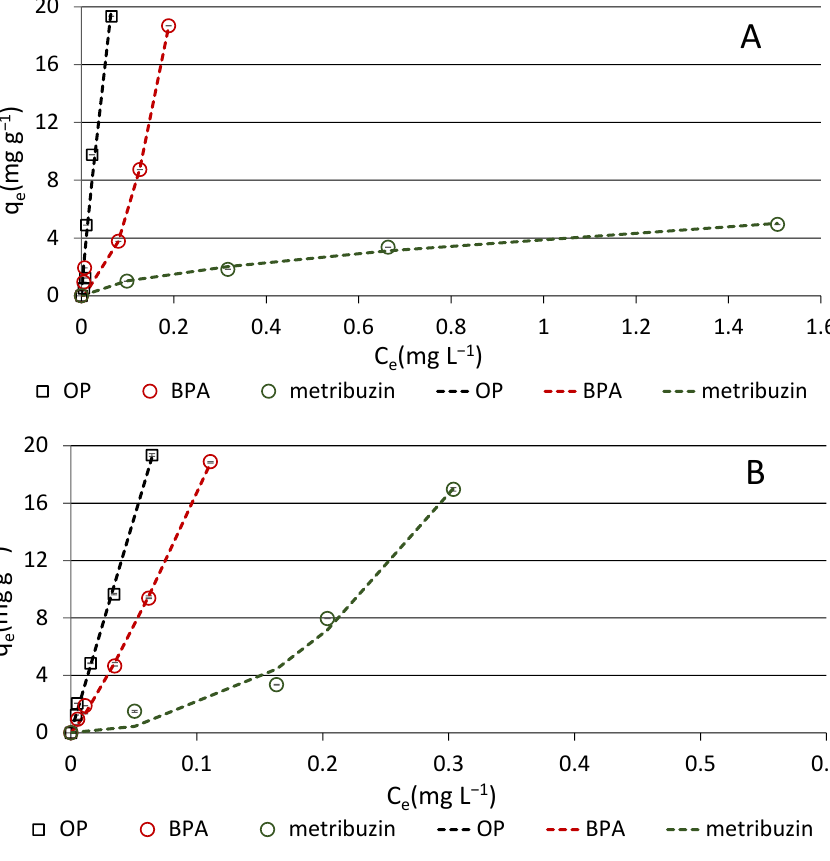
Figure 6. Adsorption isotherms of the compounds onto biochar conducted at temperatures of 10 °C ( A ) and 30 °C ( B ). Experimental points are shown along with plot (dashed lines) of the Freundlich model. Standard error is reported as vertical bar on each point (n = 3).